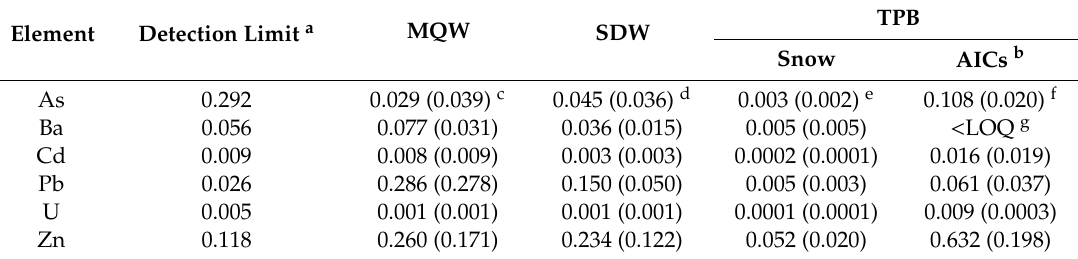
Table 1. Concentrations (in pg / g) of selected trace elements measured in ultrapure Milli-Q (MQW) and sub-boiling distilled (SDW) waters. TPB indicates the total procedural blank introduced due to the overall measurement procedure of snow samples and from the decontamination process of artificial ice cores (AICs) (see